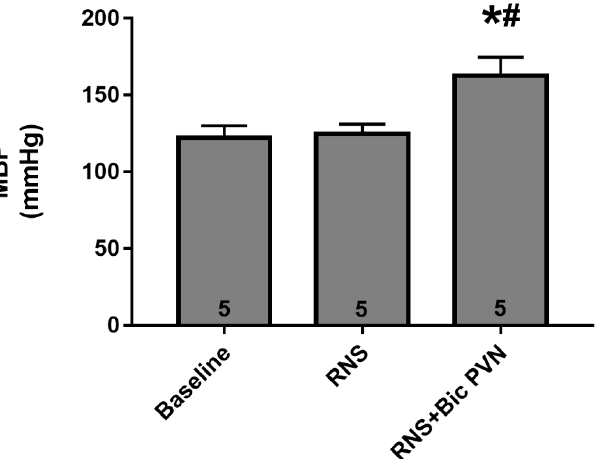
Figure 4. Mean arterial blood pressure (MBP) during the experiment at three different time points. Bars represent the mean arterial pressure (MAP) during the baseline period, under renal nerve stimulation (RNS), and under RNS plus bicuculline into the PVN (Bic PVN). The number of rats is shown inside the bars. * p < 0.001 compared to baseline. # p < 0.001 compared to RNS. One-way analysis of variance for multiple comparisons followed by Tukey’s test.